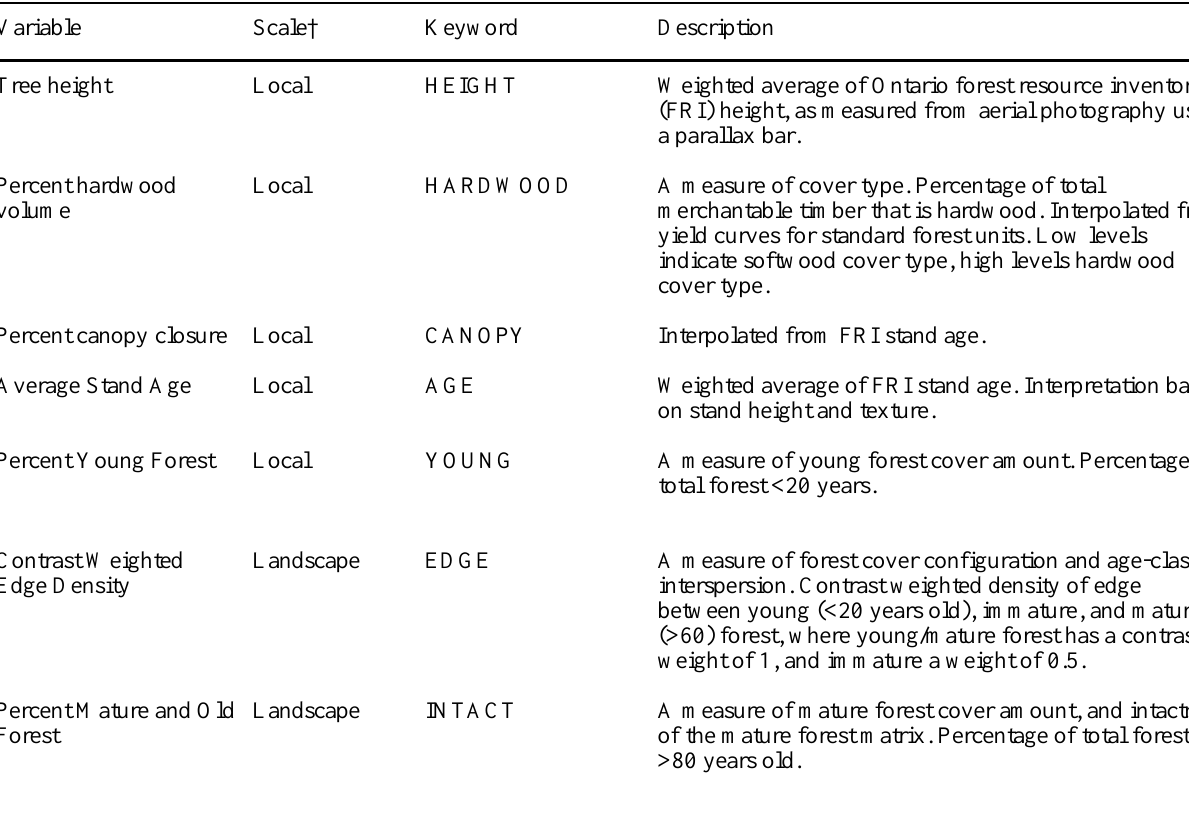
A measure of forest cover configuration and age-class interspersion. Contrast weighted density of edge between young (<20 years old), immature, and mature (>60) forest, where young/mature forest has a contrast weight of 1, and immature a weight of 0.5. >80 years